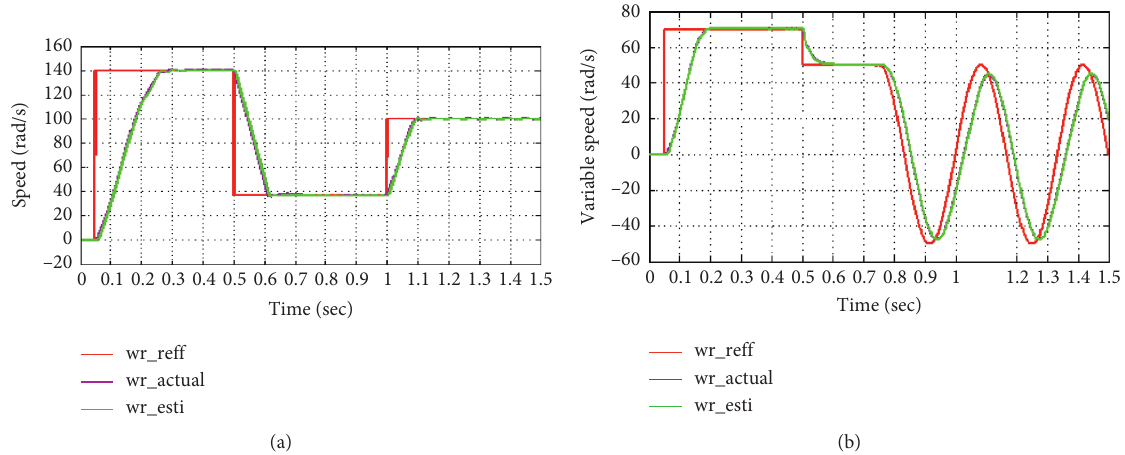
Figure 9: Variable speed step response in rad/s with a load torque of 2 Nm.